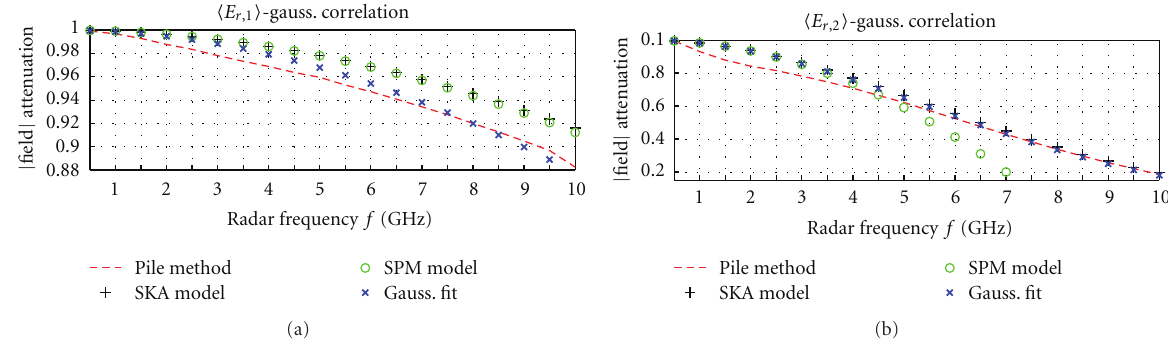
Figure 6: Frequency behavior of the amplitude attenuation of the coherent scattered fields (cid:2) E r ,1 (cid:3) and (cid:2) E r ,2 (cid:3) (V polarization) in the frequency band f ∈ [0 . 5;10 . 0]GHz, comparatively to the flat case: results from the PILE code and comparison with the SKA and SPM2 asymptotic models for Gaussian surfaces. The upper and lower correlation lengths are L c A = 4 . 0mm and L c B = 8 . 0mm, respectively.